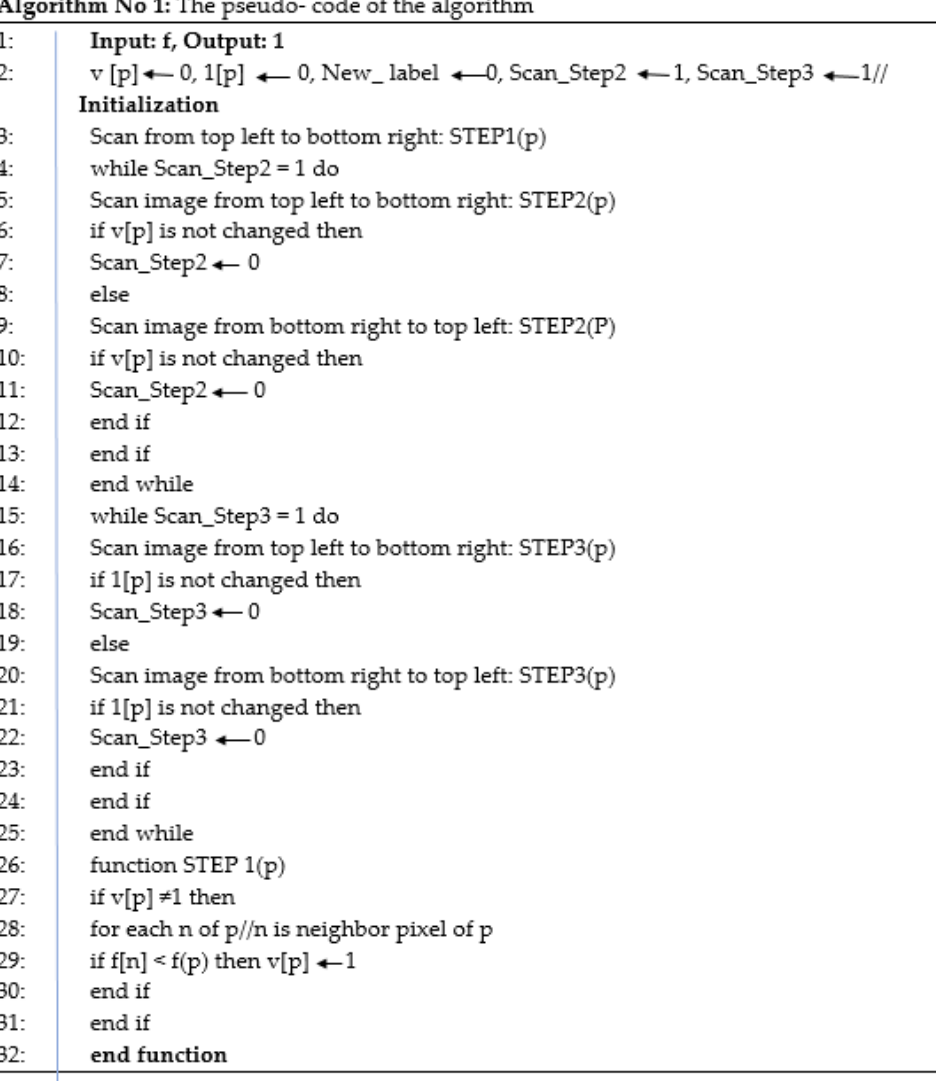
Figure 4. Pseudocode of watershed segmentation algorithm with local